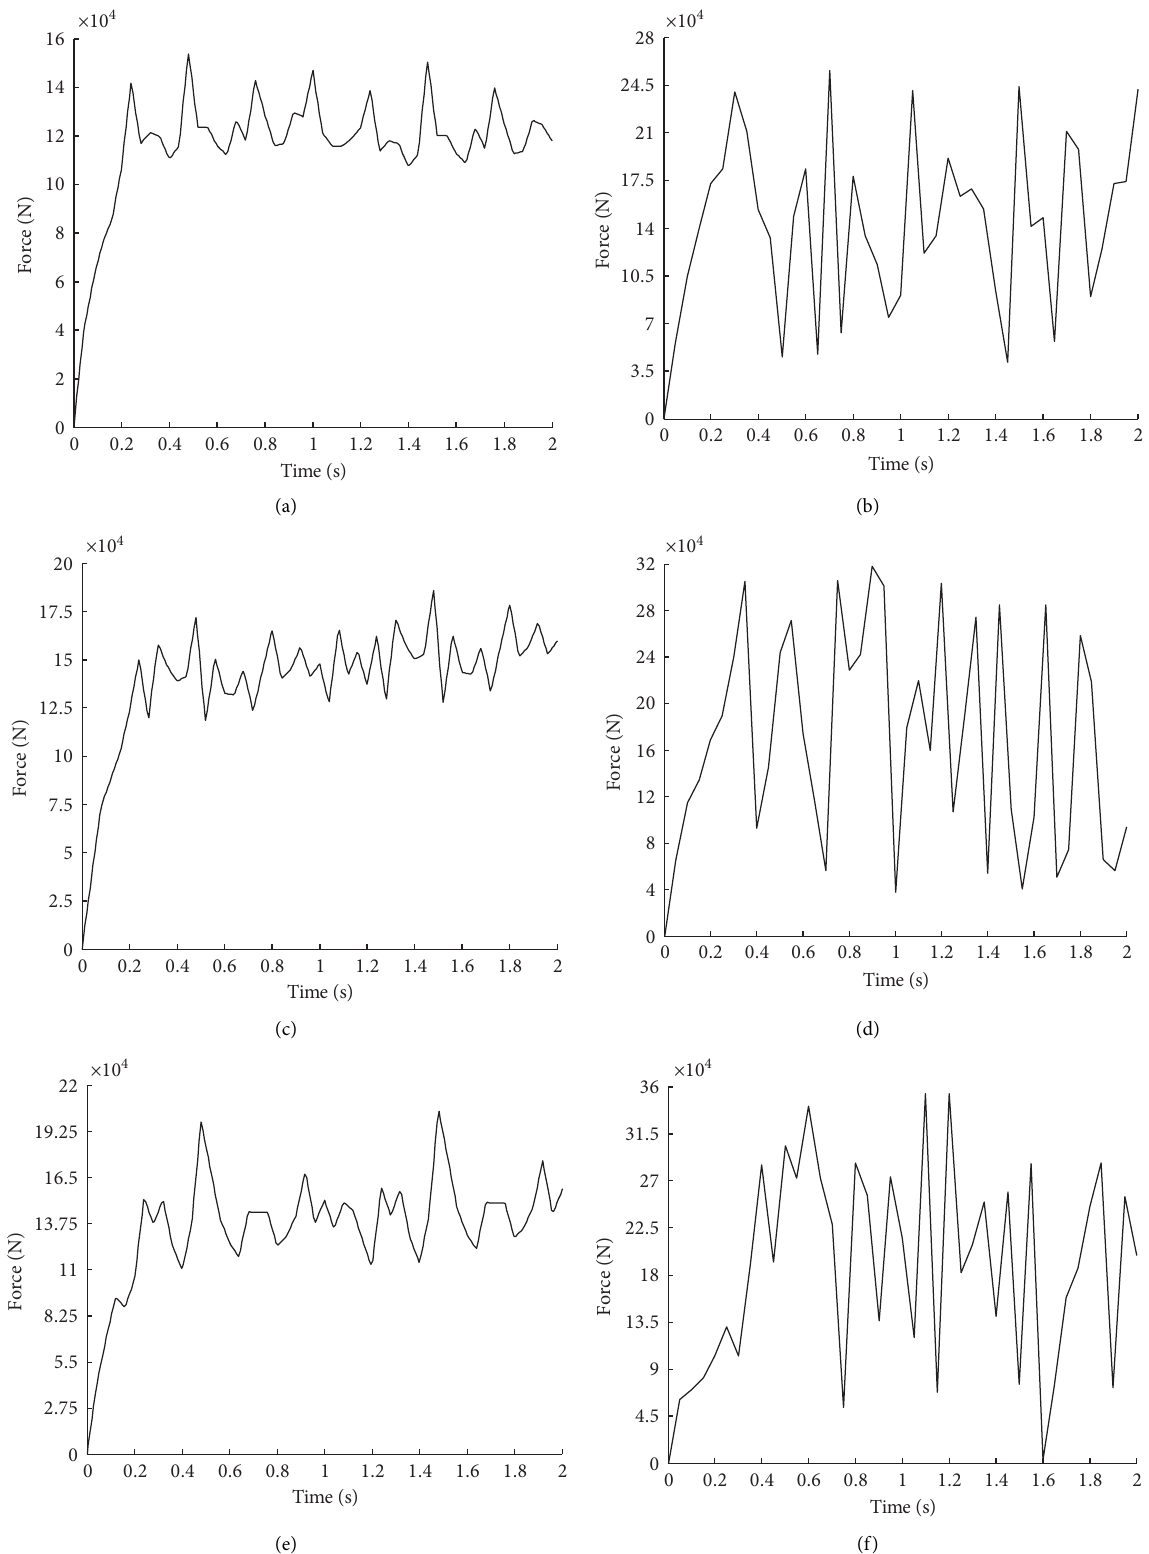
Figure 10: Force of drum for each scheme. (a) Impacting-cutting to f4. (b) Traditional to f4. (c) Impacting-cutting to f5. (d) Traditional to f5. (e) Impacting-cutting to f6. (f) Traditional to